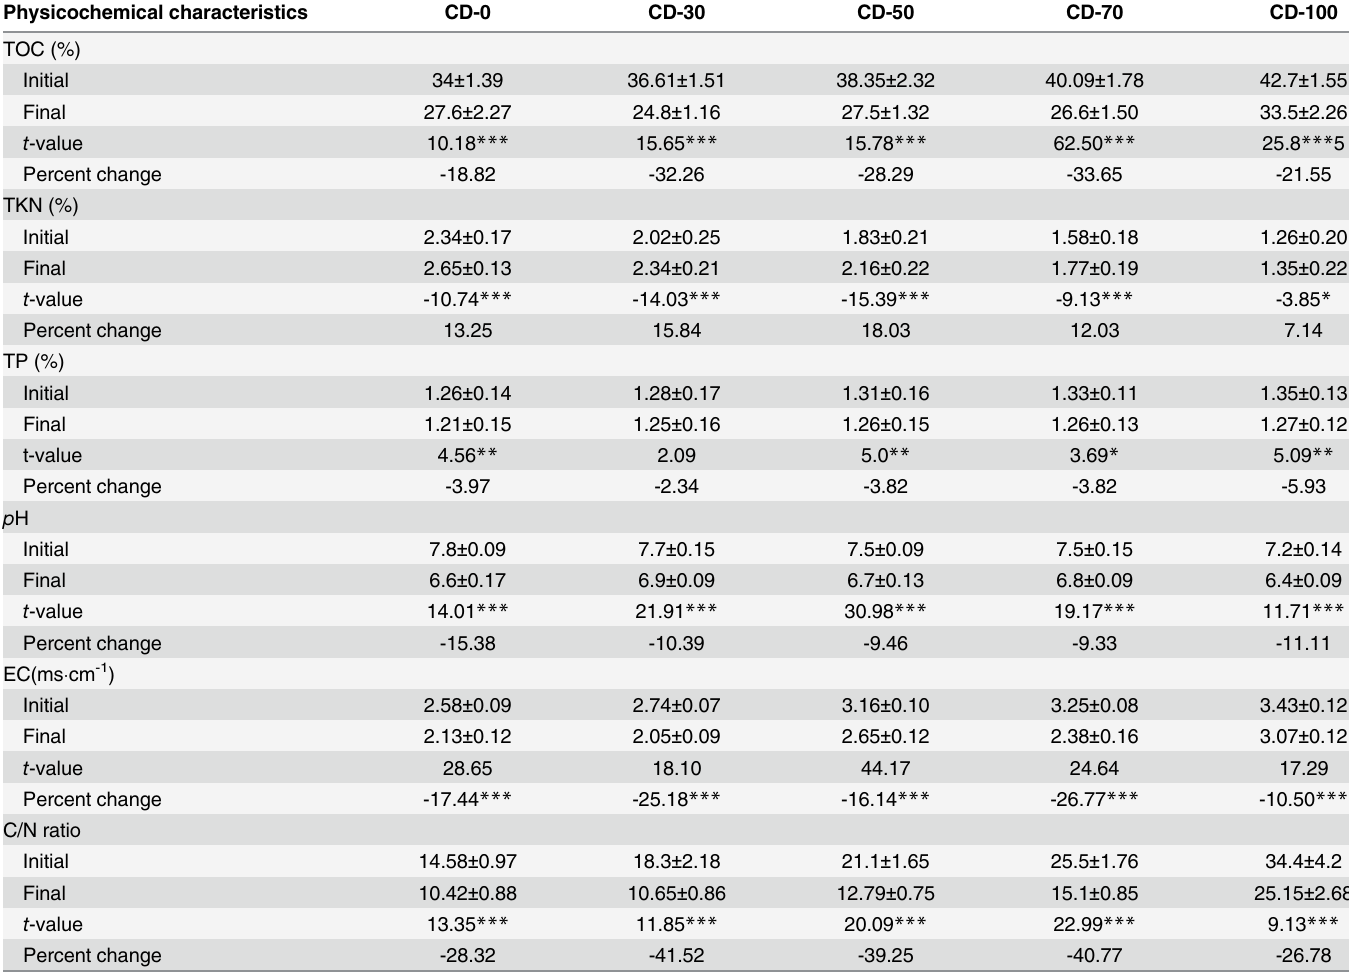
Table 2. Changes of physicochemical quality of mixture under different ratios of sewage sludge and cattle manure. Physicochemical